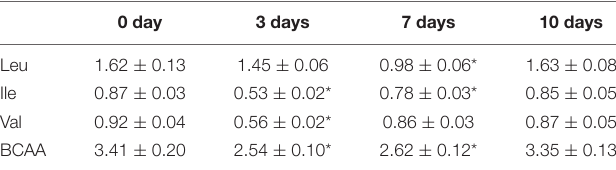
TABLE 2 | Effect of starvation on BCAA content in the skeletal muscle of Nile tilapia (g/100 g).